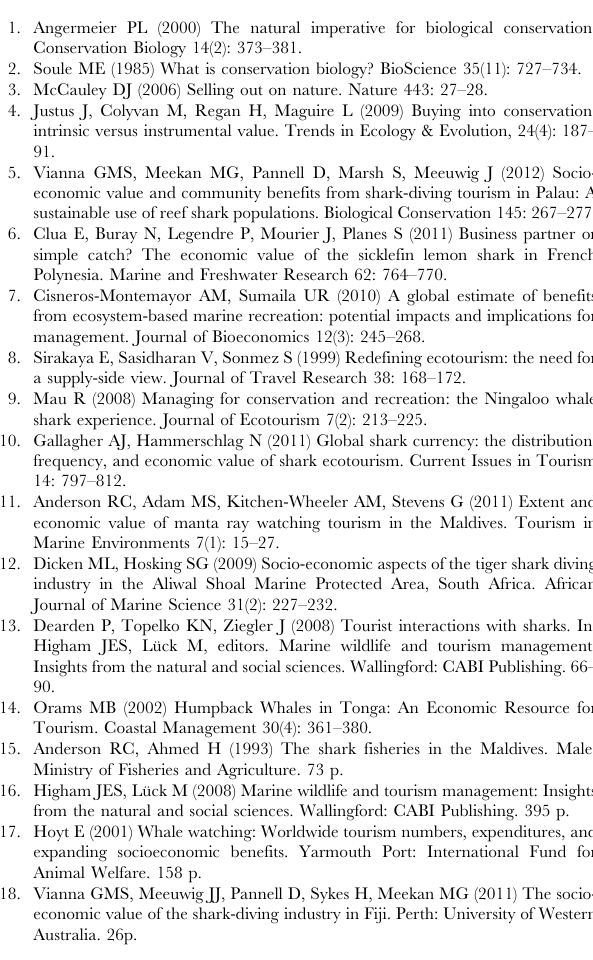
Table S1 Manta Ray Watching Tourism Extent and Dive Expenditure Estimates. Research results used to calculate the country totals summarized in Table 2. (PDF)